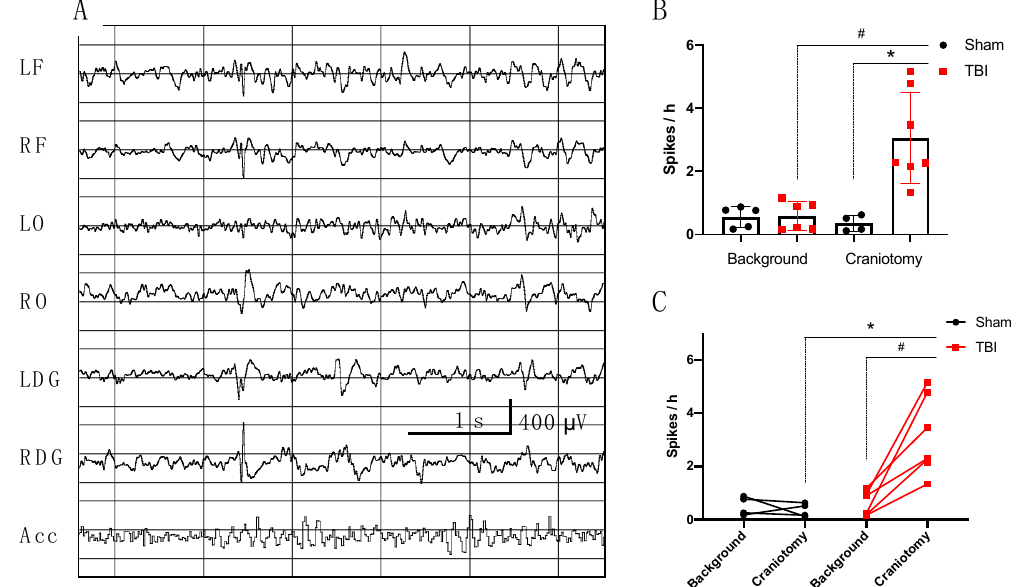
Figure 5. High-amplitude spikes before and after TBI in rats. ( A ) High-amplitude spikes 7 days after TBI. The spikes are evident on ECoG (LF, RF), but maximum amplitude was recorded in the ipsilateral hippocampal DG (HLFP); ( B ) Spike occurrence increased after TBI as compared with either background or sham-operated animals; ( C ) Spike occurrence in individual animals before and after TBI. n = 7 (TBI), n = 5 (Sham). * p < 0.05, Sham vs. TBI, Mann–Whitney test; # p < 0.05, background vs. craniotomy, Wilcoxon test; LF, left frontal cortex; RF, right frontal cortex; LO, left occipital cortex; RO, right occipital cortex; LDG, left dorsal hippocampus; RDG, right dorsal hippocampus; Acc, accelerometer.